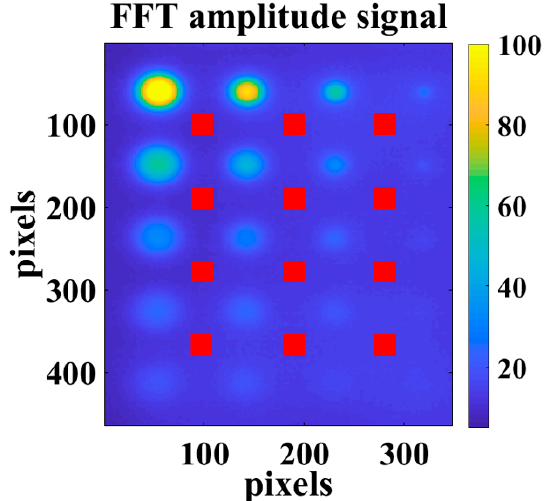
Figure 8. An example of the obtained thermographic map (PPT, amplitude) with in red the areas chosen as sound; (0.3906 Hz with 512 analyzed frames).